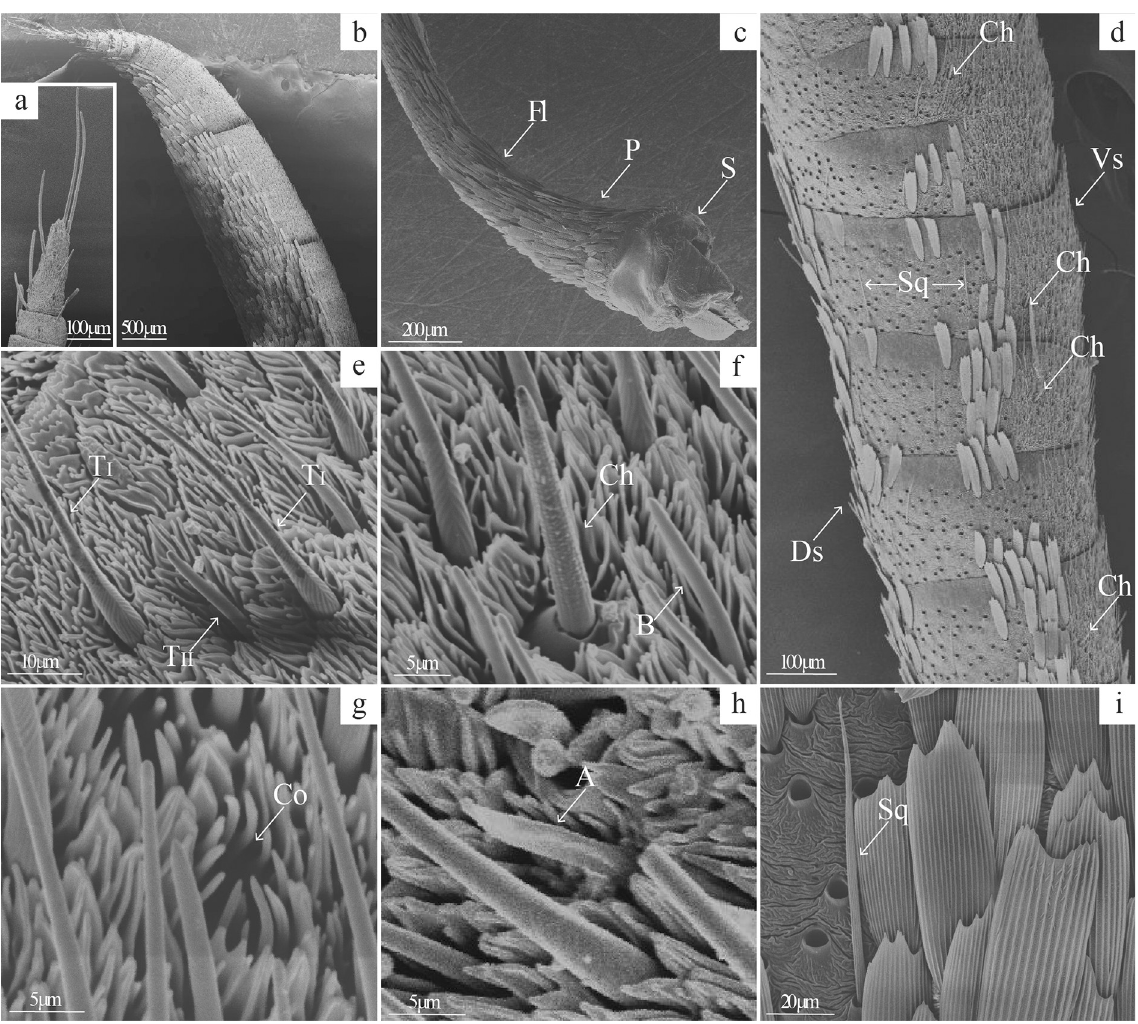
Fig 2. General morphology of male and female Telchin licus antennae. Microphotographs showing the (a) apiculus; (b) club; (c) antenna base with a scape (S), a pedicel (P) and the first segments of the flagellum (F1); and (d) flagellum composed of ventral (Vs) and dorsal (Ds) surfaces with squamiform (Sq) and chaetic (Ch) sensilla. (e) Trichoid sensilla (TI, TII). (f) Basiconic sensilla (B) and chaetic sensilla (Ch). (g) Coeloconic sensilla (Co). (h) Auricillic sensilla (A). (i) Squamiform sensilla (Sq).